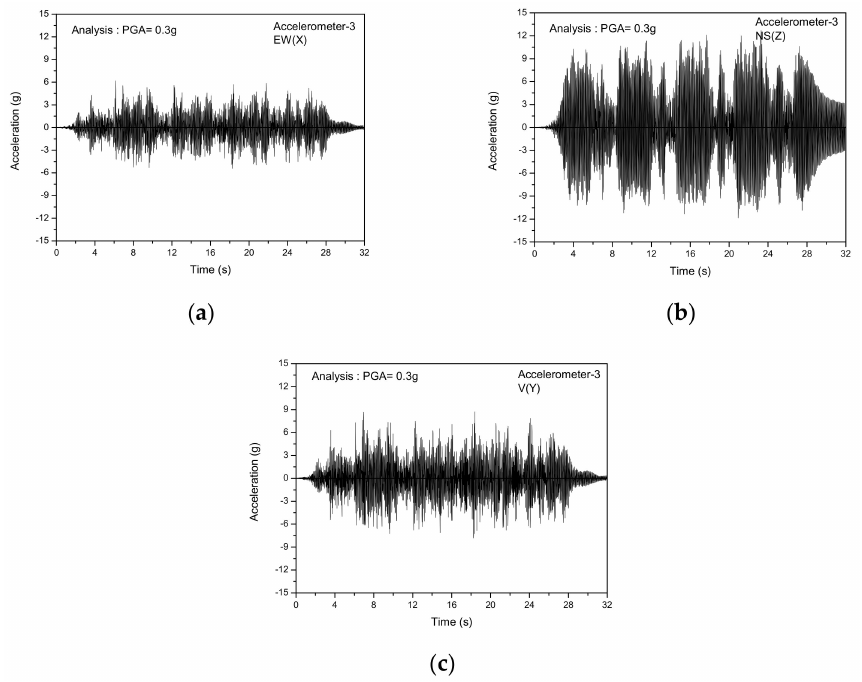
Figure 22. Inelastic seismic analysis results of acceleration responses at Accelerometer-3 for PGA = 0.3 g: ( a ) EW (X); ( b ) NS (Z); ( c ) V